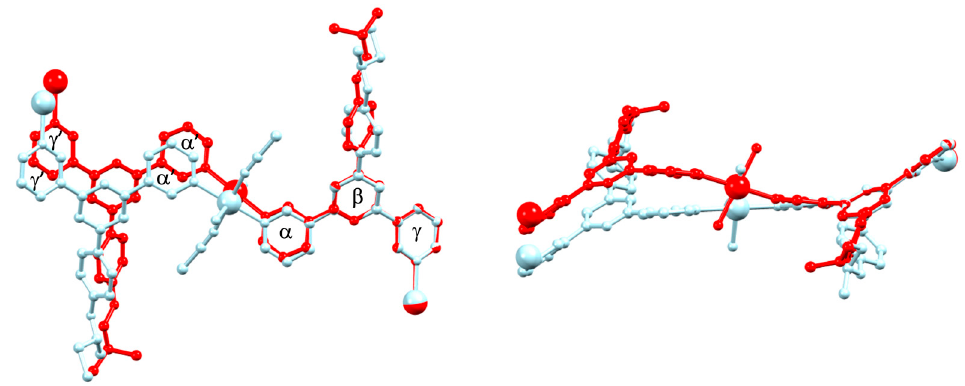
Figure 7. Overlay of parts of the structures of [Co( 3 ) 2 (NCS) 2 ] n (red) and [{Co( rac - 2 ) 2 (NCS) 2 } · CHCl 3 ] n (pale blue). Thiocyanato ligands and H atoms are omitted. See text for details.